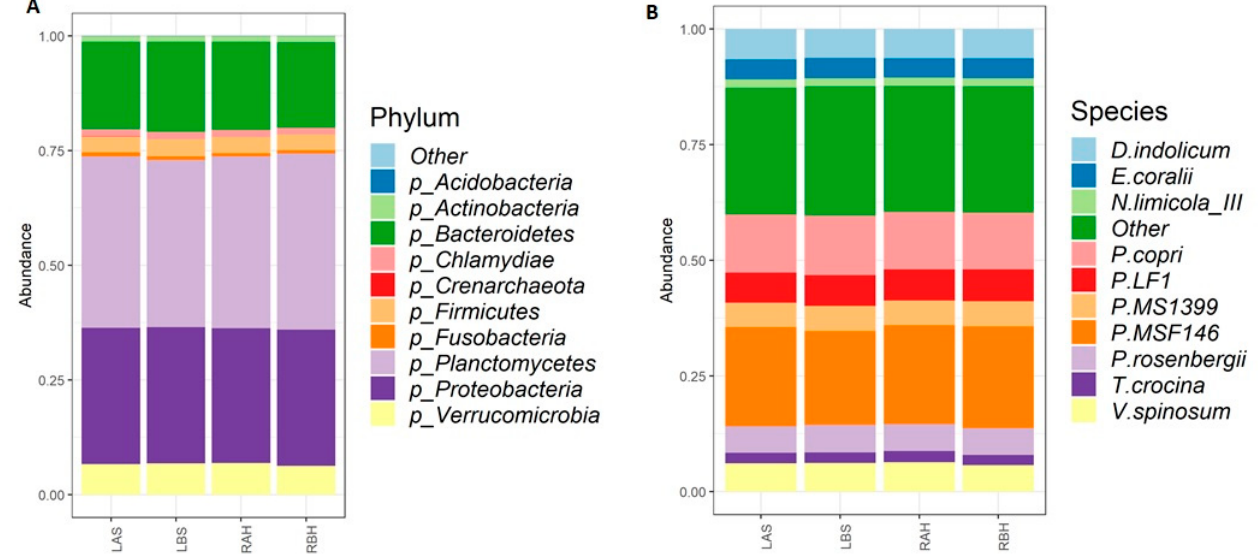
Figure 3. Nasal microbiome composition in AtR: relative abundance of top 10 bacterial taxa at ( A ) phylum-level and ( B ) species-level composition in all four study groups, left side after saline treatment (LAS), left side before saline treatment (LBS), right side before honey treatment (RBH), and right side after honey treatment (RAH). Desulfobacterium indolicum ; Enterovibrio coralii ; Nostocoida limicola lll; Prevotella copri ; Planctomycete LF1; Planctomycete MS1399; Planctomycete MSF146; Photobacterium rosenbergii ; Tamlana crocina ; Verrucomicrobium spinosum .